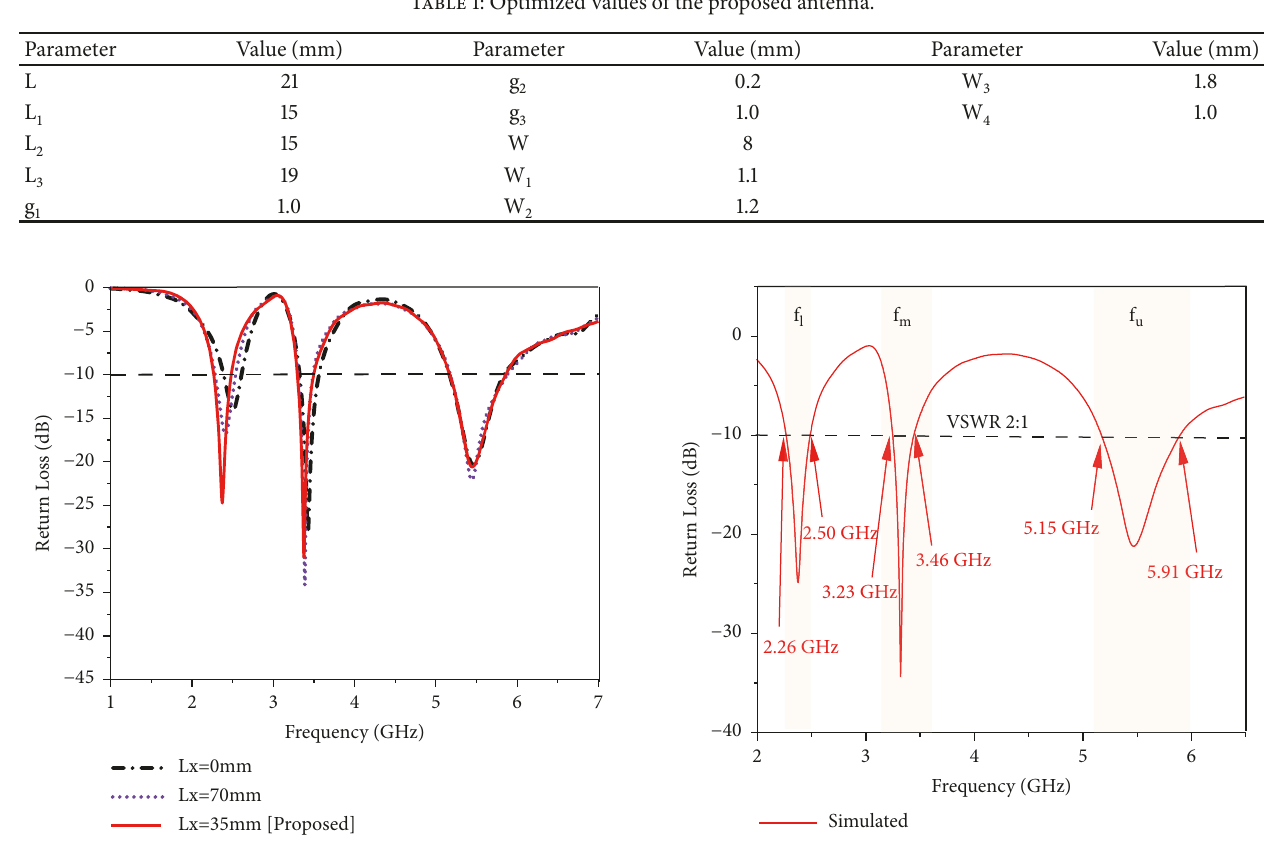
Figure 5: Simulated return loss of proposed antenna as a function of L x for mounting the proposed antenna on the system ground.